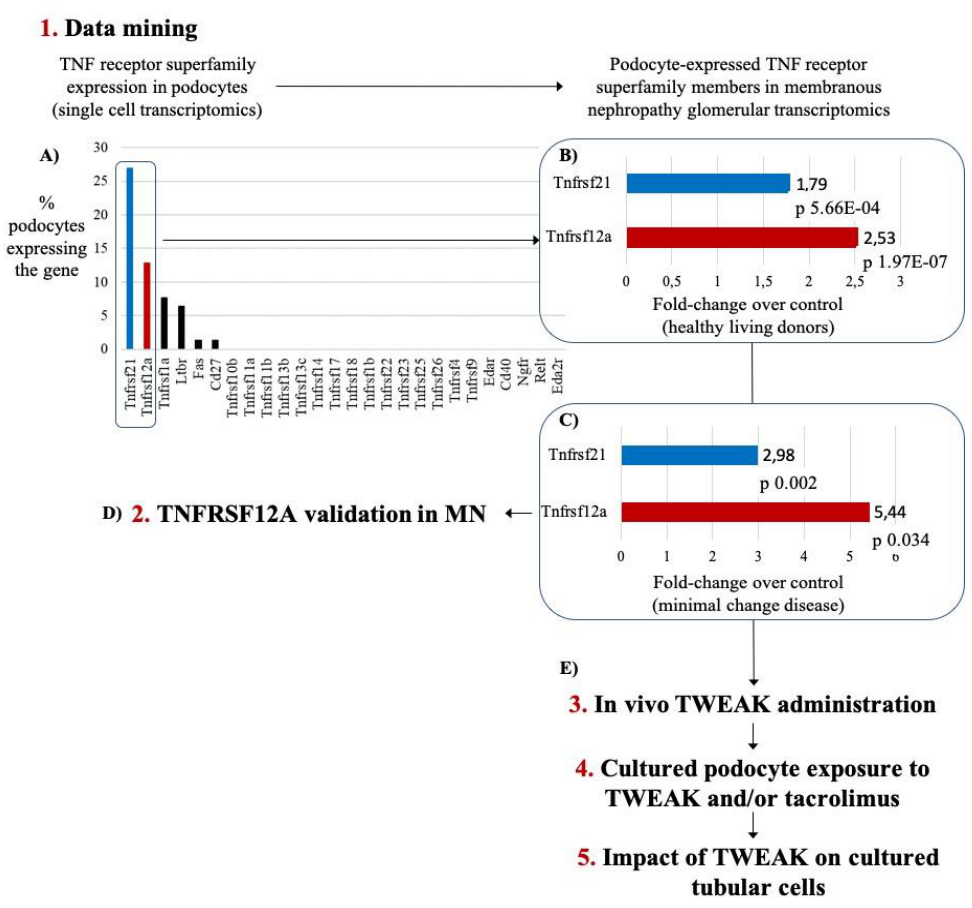
Figure 1. Experimental design and glomerular expression of TNF receptor superfamily (TNFRSF) members in human membranous nephropathy (MN). (A) Data mining (Step 1). Initially,